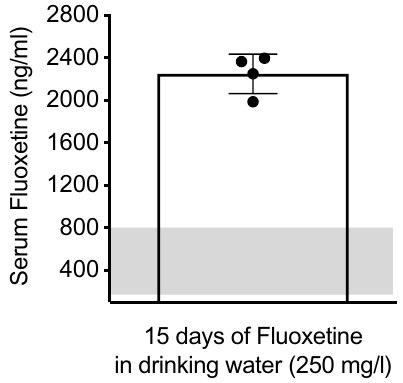
Figure 7. Plasma fluoxetine levels. Plasma fluoxetine levels are shown in ng/ml for adolescent (postnatal day 49) female C57BL/6 mice receiving 250 mg/l of fluoxetine in their drinking water (for 15 days). The gray area displays plasma fluoxetine levels in humans taking 20–80 mg fluoxetine per day 63,65